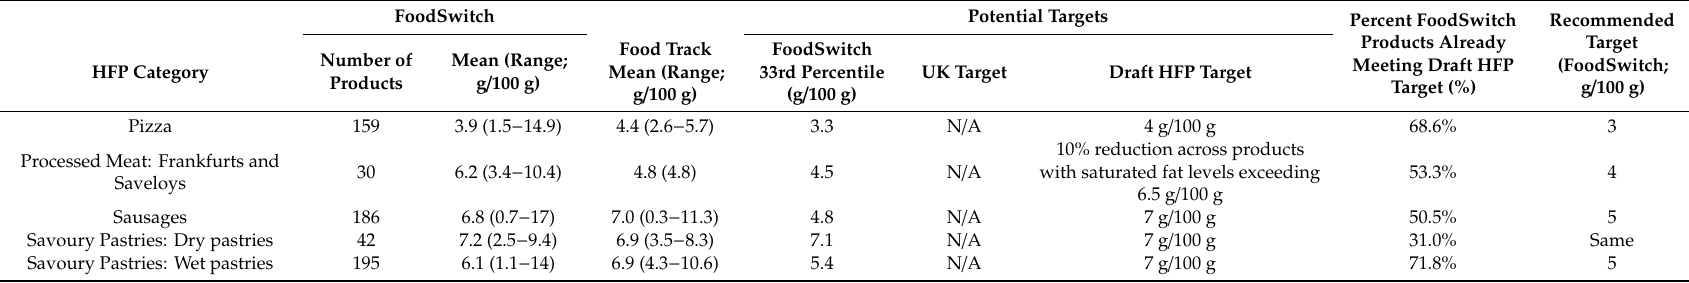
Table 2. Saturated fat levels of products included the FoodSwitch and FoodTrack databases, potential reformulation targets, and recommended targets based on FoodSwitch data.